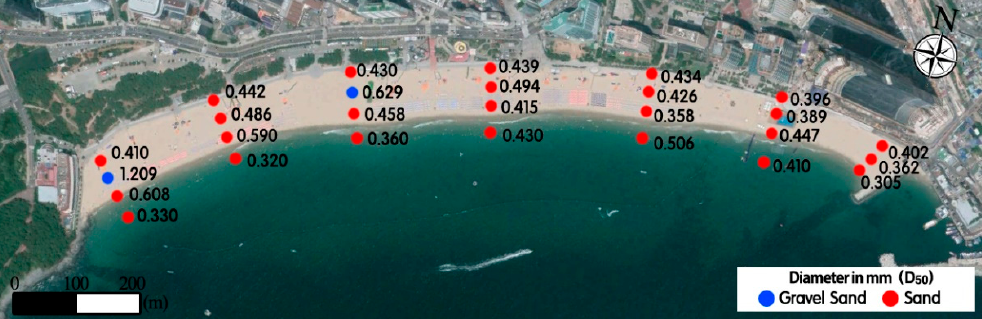
Figure 3. Grain characteristics of the sand sampling along Haeundae Beach.